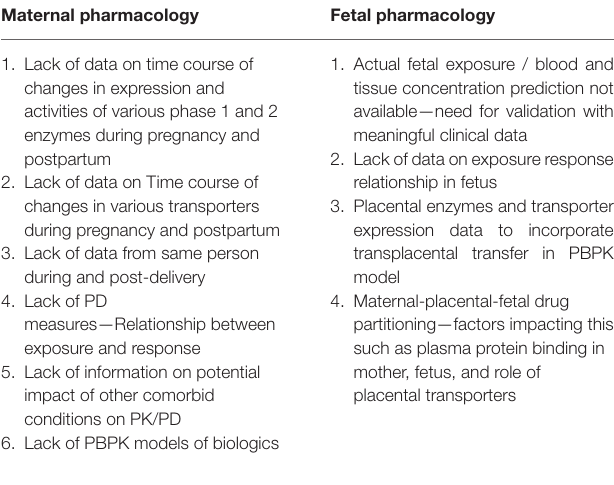
TABLE 6 | Current gaps in modeling maternal-fetal pharmacology.